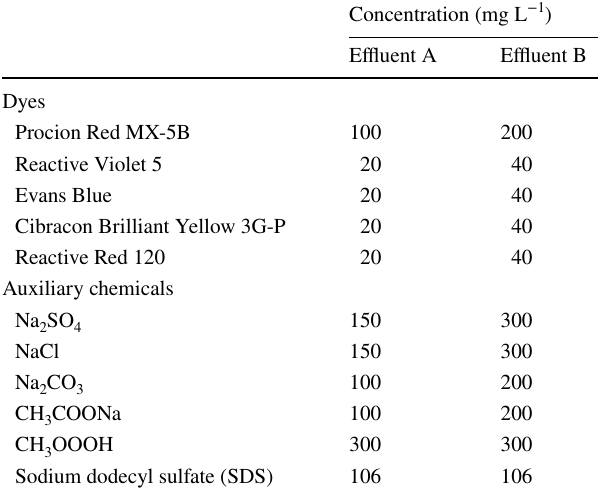
Table 1 Chemical composition of the simulated dye-house